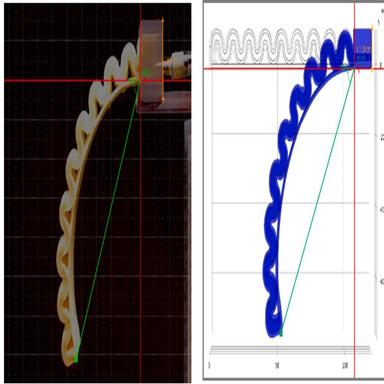
Displacement analysis (10 psi).